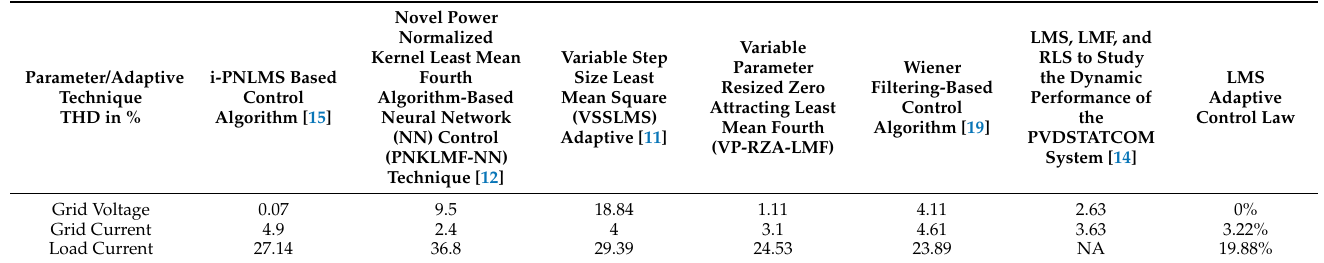
Table 7. Comparison between the d-q based LMS control algorithm and other adaptive control law with other author’s results.